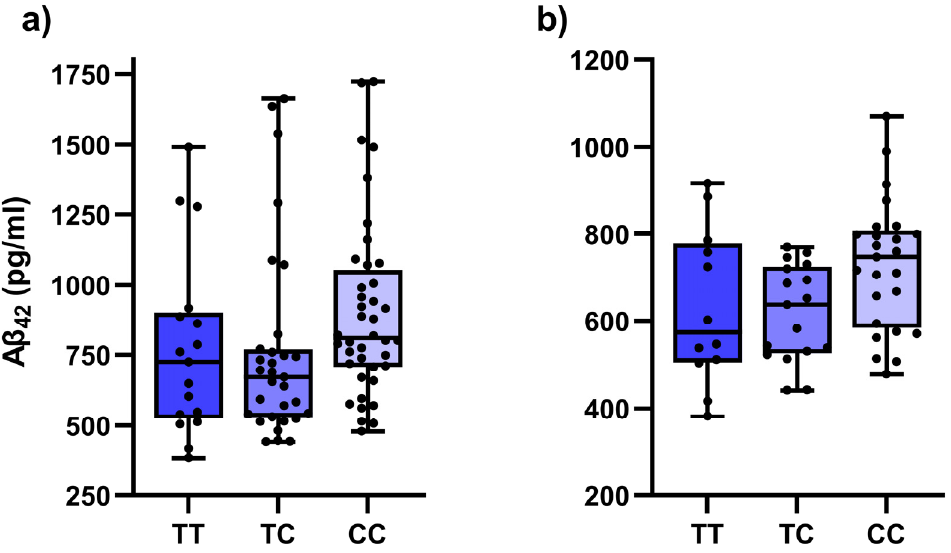
Figure 1. Comparison of A β 42 cerebrospinal fluid levels between different IL1B rs16944 genotypes in: ( a ) whole patient cohort; ( b ) Alzheimer’s disease patients only. Table 4. Association of investigated polymorphisms with cognitive test scores among all patients with dementia and AD